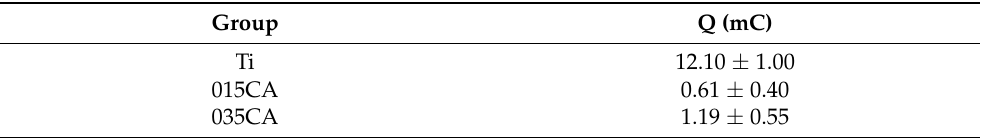
Table 3. Electric charge (Q) transfer between the worn surfaces and electrolyte.